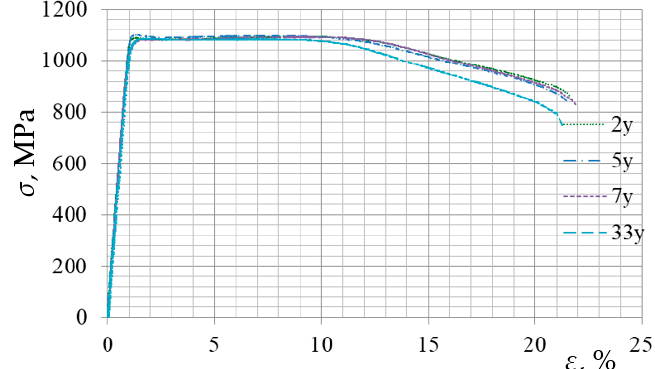
Figure 7. Stress ‐ strain diagrams of the tested specimens from the VT23 alloy (loading schemes are described in Table 5).